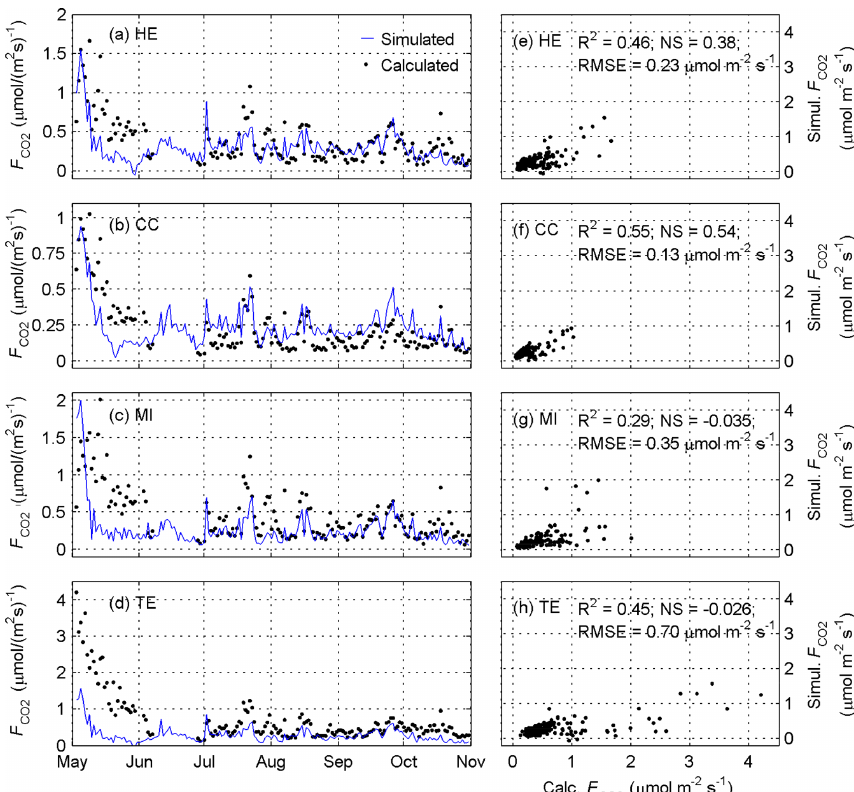
Figure 5. Simulated and calculated air–water CO 2 fluxes (µmolm − 2 s − 1 ) in Lake Kuivajärvi on 3 May–31 October 2013 obtained with the gas exchange models by (a, e) Heiskanen et al. (2014), (b, f) Cole and Caraco (1998), (c, g) MacIntyre et al. (2010), and (d, h) Tedford et al. (2014).